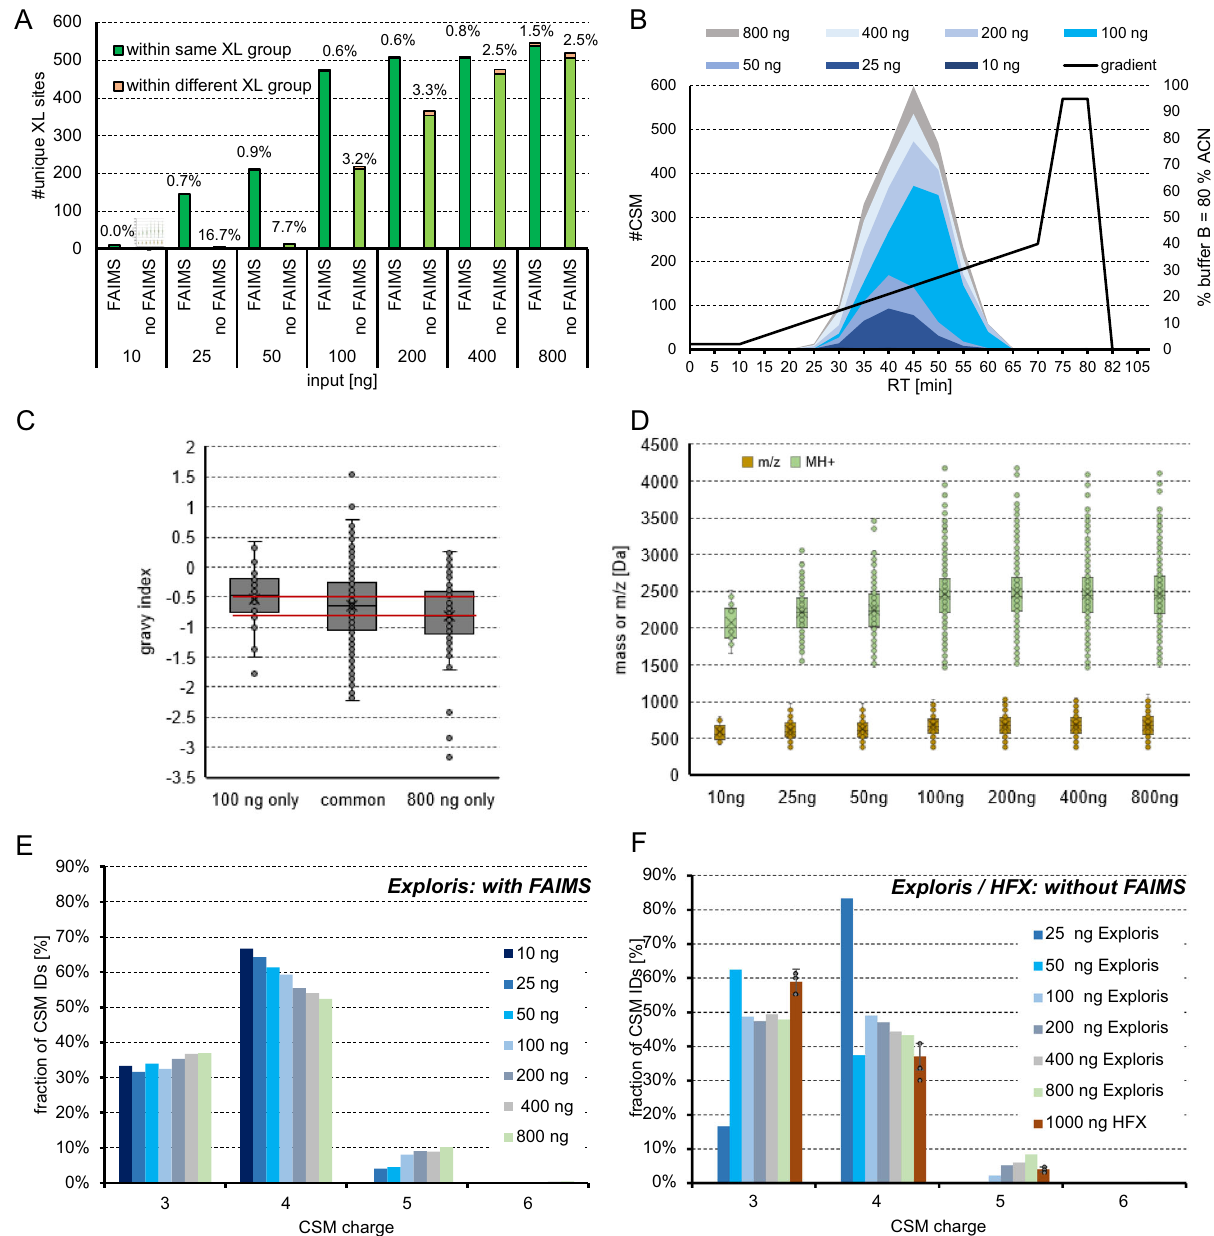
Fig. 8 Variation of input amount and physicochemical properties of crosslinks. Lowered input amounts, as indicated, of the DSSO cross-linked main library were measured on an Orbitrap Exploris 480 using a stepped HCD MS2 strategy. Data was analyzed using MS Annika at 1 % FDR. A Unique crosslinks with or without FAIMS attached and experimentally validated FDR is given above bars. B Distribution of spectral matches over retention time and used gradient with FAIMS. C Distribution of hydrophobicity of CSMs identi fi ed exclusively in the 100 or 800 ng sample or in both samples (measured with FAIMS). D Distribution of identi fi ed cross-linked peptide masses of CSMs (M + H) and m/z in dependence of used input amount. (measured with FAIMS) C , D Boxplots depict the median (middle line), upper and lower quartiles (boxes), 1.5 times of the interquartile range (whiskers) as well as outliers (single points), this data is from a single replicate. E Charge distribution obtained with FAIMS using CVs − 50, − 55 and − 60 for acquisition and stepwise changing the input amount from 10 – 800 ng or ( F ) without FAIMS when acquiring on HFX or Exploris instrument. Error bars indicate standard deviations of average values, experimentally validated FDR is shown as callout, n = 3 independent samples acquired on different days. Source data are provided as a Source Data fi crosslinked using DSSO (Fig. 9). In line with previous results Eclipse Tribrid mass spectrometer (Thermo Fisher Scienti fi c). from our group 17,22 , stepped HCD outperformed MS3 and MS2- Data analysis was performed using XlinkX at 1 % FDR on CSM MS2 results in terms of unique crosslink numbers. We however and residue pair level. MS3 35 methods are reported as more reliable for crosslink identi fi cation when using cleavable cross- observed a slight increase in FDR (8.5% vs 7.6 and 7.2% for MS3 linker. Therefore, MS3 (acquired as described in 35 ) was compared and MS2-MS2 respectively). Surprisingly, the experimentally to an MS2-MS2 method (acquired as described in 22 ) and our validated FDR for MS3 is higher with lower unique residue pair standard stepped HCD acquisition method for the main library numbers than for the MS2-MS2 method which contrasts with the